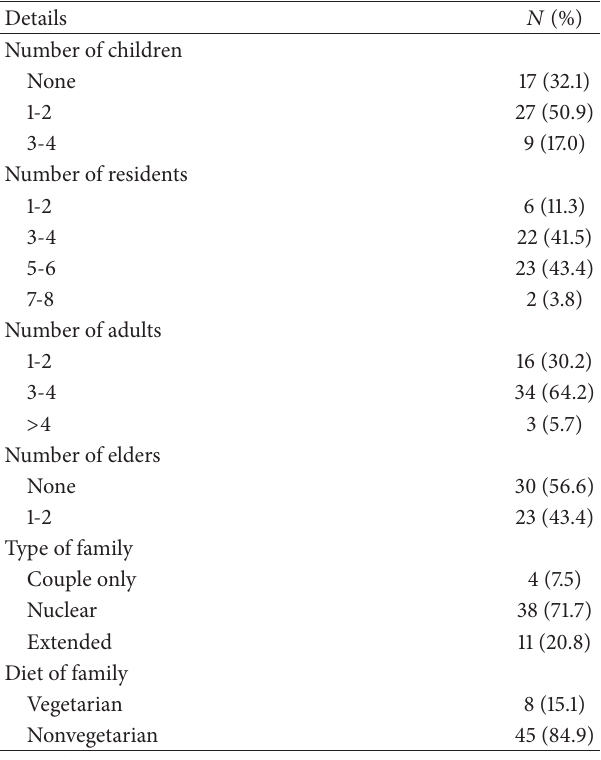
Table 1: Demographic details of